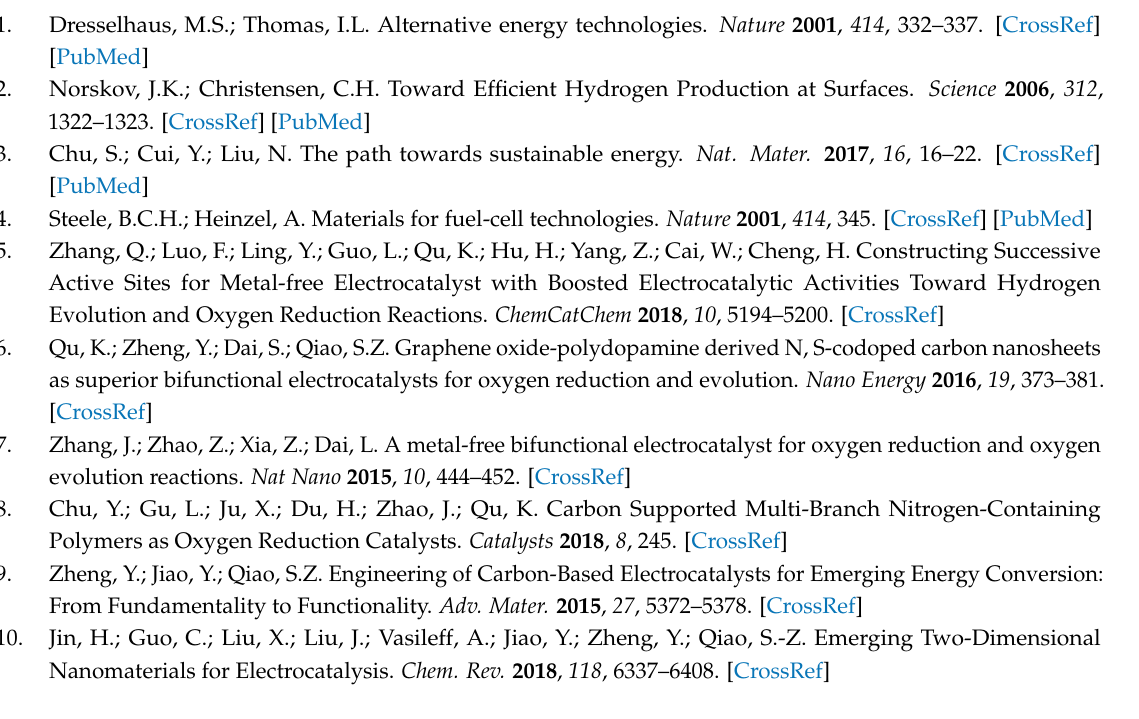
s1, Figure S1: SEM image of N, O-CNT, Figure S2: The magnified TEM images of the N, O-CNT, Figure S3: XPS high-resolution spectra of C1s of N, O-CNT, Figures S4 and S5: XPS survey scans and the deconvoluted high-resolution spectra of p-CNT and ox-CNT. Figure S6: LSVs at different rotating speeds from 0 to 2400 rpm and the K-L plots obtained at different potentials, Table S1: Comparison of the different OER and ORR metrics of the obtained